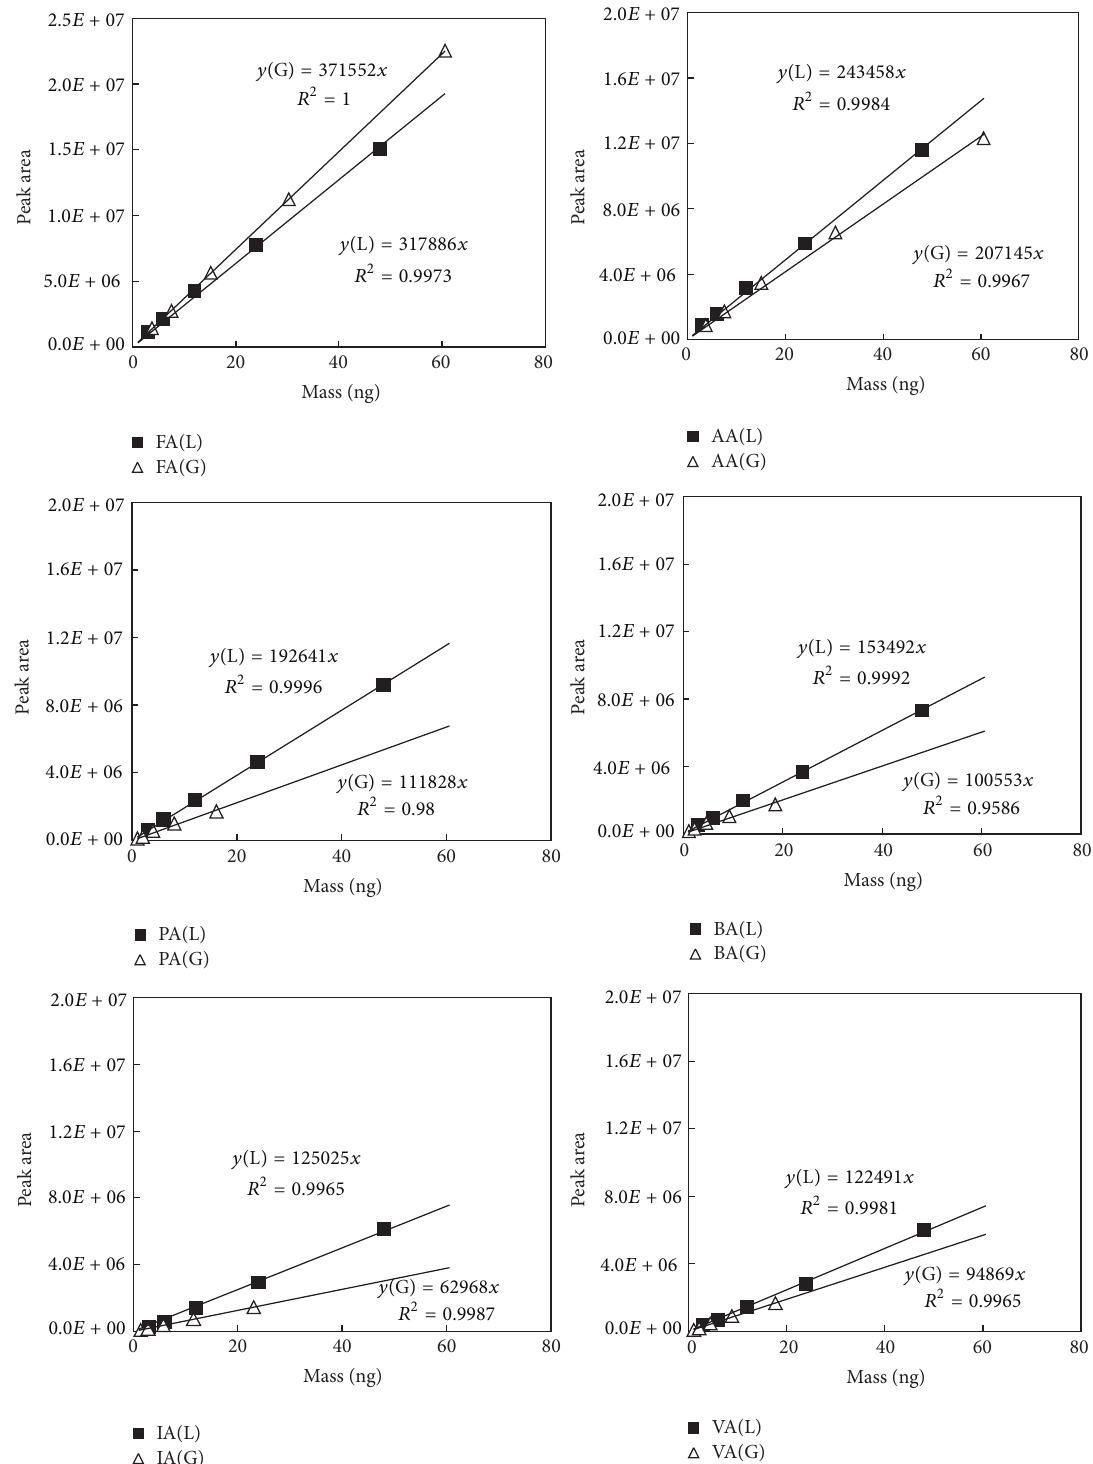
Figure 1: Comparison of HPLC-based calibration curves of CCs between liquid- (L) and gas-phase (G)